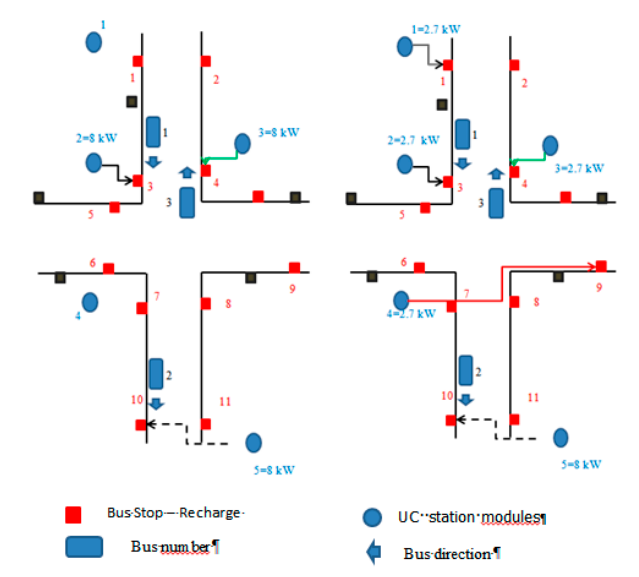
Figure 13. Bus position and configuration of the charging network for 6’ < T < 9 (cid:48) in the two